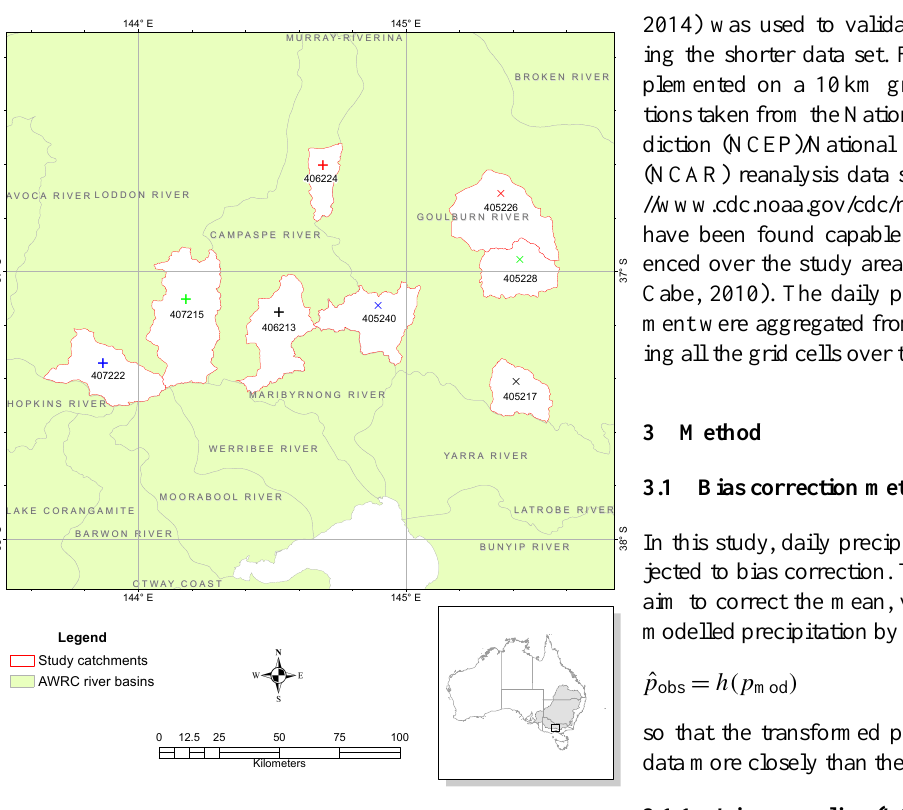
Figure 1. Map showing the eight study catchments (white with red outline, large map), and their locations within the major river basins devised by the Australian Water Resources Council (AWRC). The unique symbols in each catchment identify the catchments and will be used in later